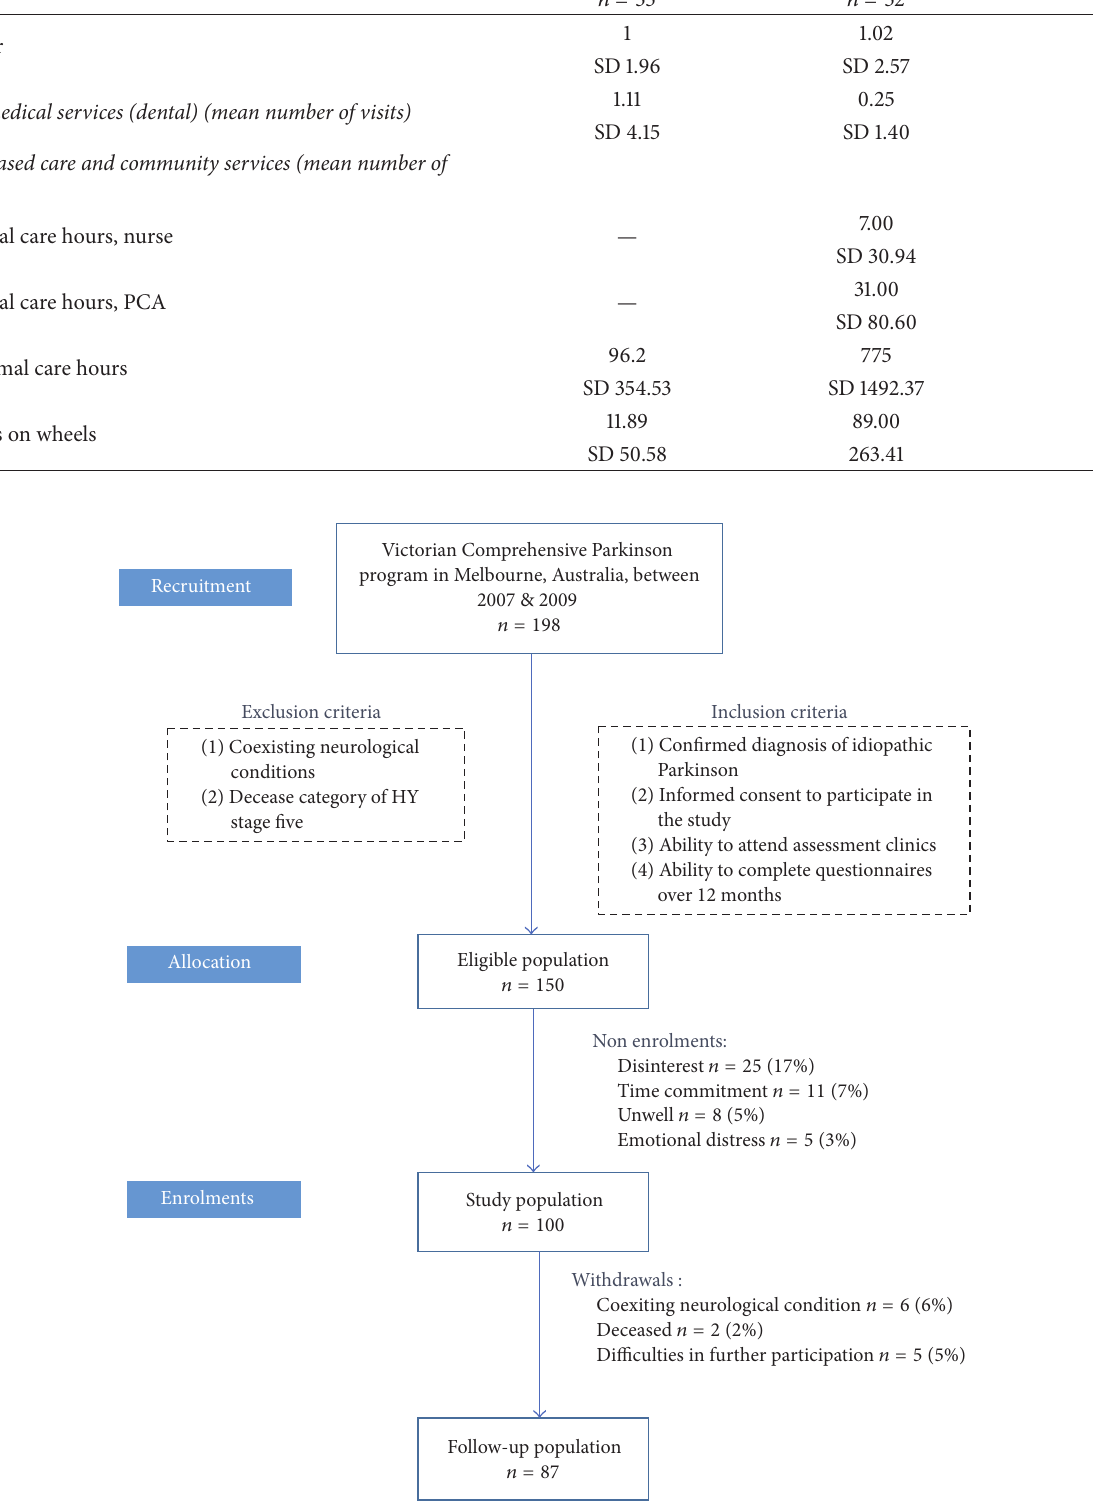
Figure 1: Consort chart; study